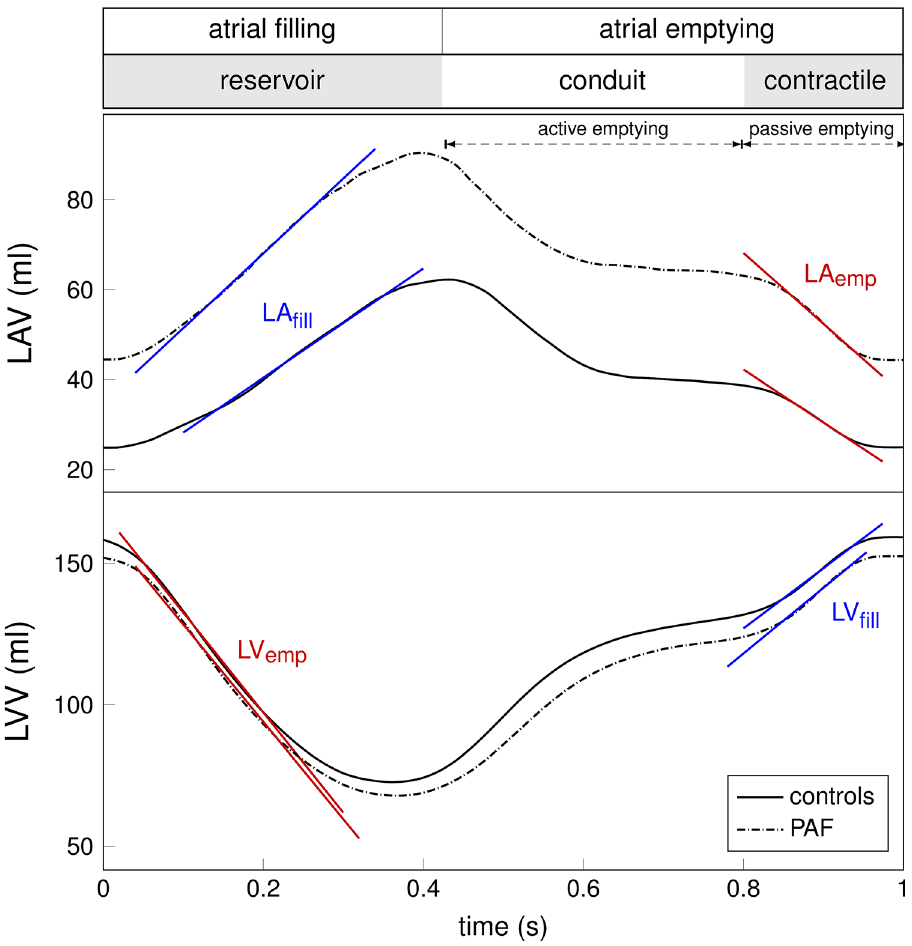
Figure 2. Volume curves derived from CMR-FT. Schematics of the volume vs time curve slope calculation for the left atrium (LA) (upper panel, LAV) and left ventricle (LV) (lower panel, LVV) indicated phases. The curves shown are the average of the controls’ (solid) and the PAF patients (dash-dotted) measurements. CMR cardiovascular magnetic resonance, FT feature tracking, LA left atrium, LA emp LA volume emptying, LA fill LA volume filling, LAV LA volume, LV left ventricle, LV emp LV volume emptying, LV fill LV volume filling, LVV LV